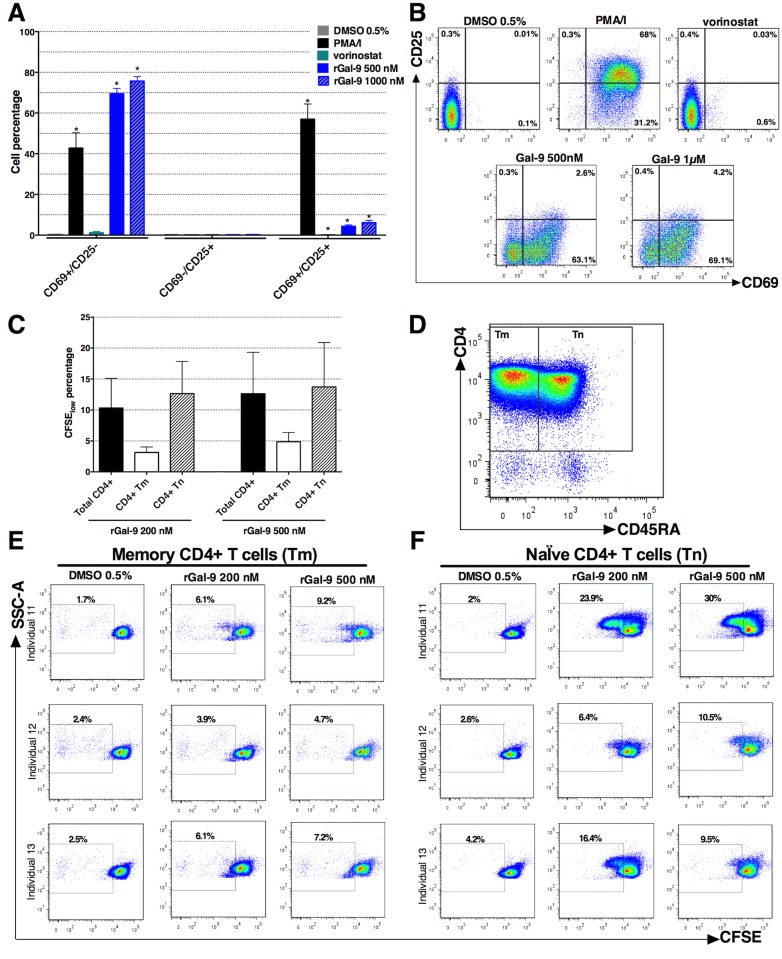
rGal-9 partially activates primary CD4+ T cells and induces proliferation primarily in naïve CD4+ T cells.(A, B) Effects of rGal-9 stimulation on the cell surface expression of CD69 and CD25 activation markers on CD4+ T cells isolated from six ART-suppressed individuals. Mean ± SEM is displayed. Asterisks represent statistically significant differences as compared to DMSO control (p < 0.05, two-tailed Wilcoxon signed-rank test). (C) Effects of rGal-9 stimulation on the proliferation of CD4+ T cells isolated from three ART-suppressed individuals. Primary CD4+ T cells were stained with CFSE and cultured for 5 days, stained with CD4 and CD45RA monoclonal antibodies, and proliferation was quantified as the percentage of CFSElow cells on CD4+ CD45RA+ (Naïve, Tn) or CD4+ CD45RA- (Memory, Tm) T cells. Mean ± SEM is displayed. (D) Example of the flow cytometry gating strategy. (E, F) Effects of rGal-9 on proliferation of (E), memory CD4+ T cells, and (F), naïve CD4+ T cells.